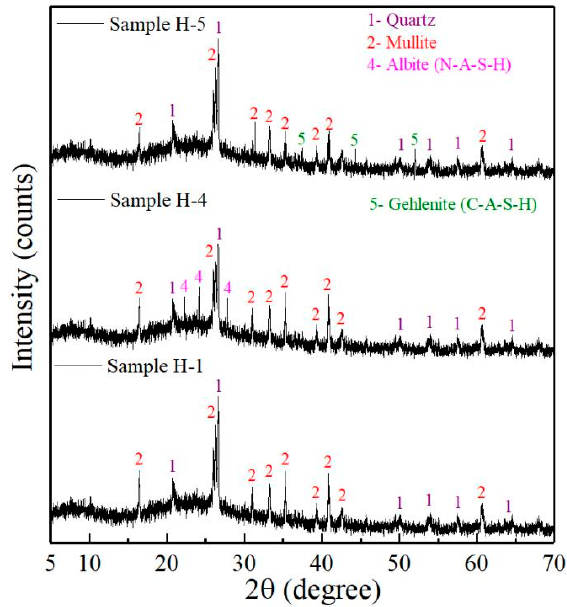
Figure 3. XRD patterns of the single activators.